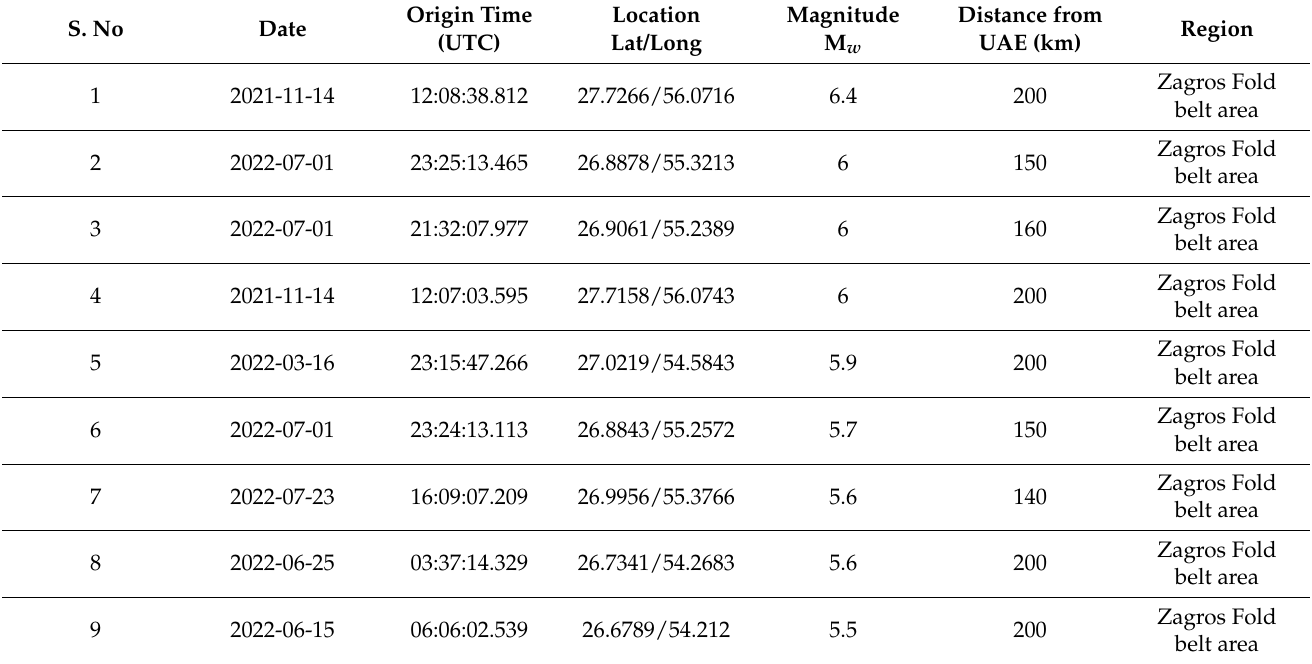
Table 3. The major earthquakes with magnitude more than 5.5 in the region for the last